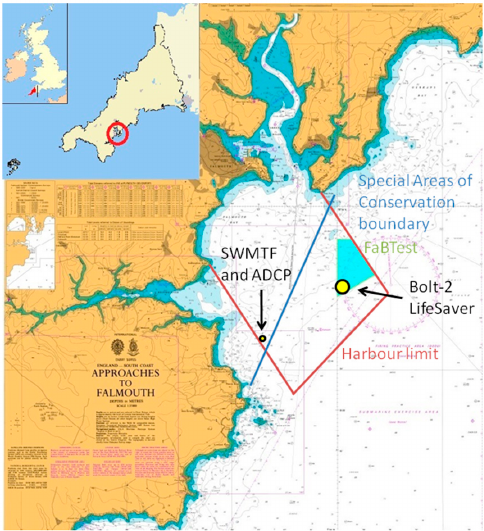
Figure 1. South West Mooring Test Facility (SWMTF) and the Falmouth Bay Test Site (FaBTest) locations, adapted from the United Kingdom Hydrographic Office (UKHO) admiralty chart. ADCP: acoustic Doppler current